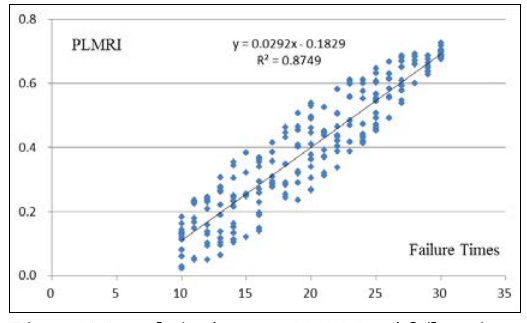
Figure 10 Correlation between PLMRI and failure